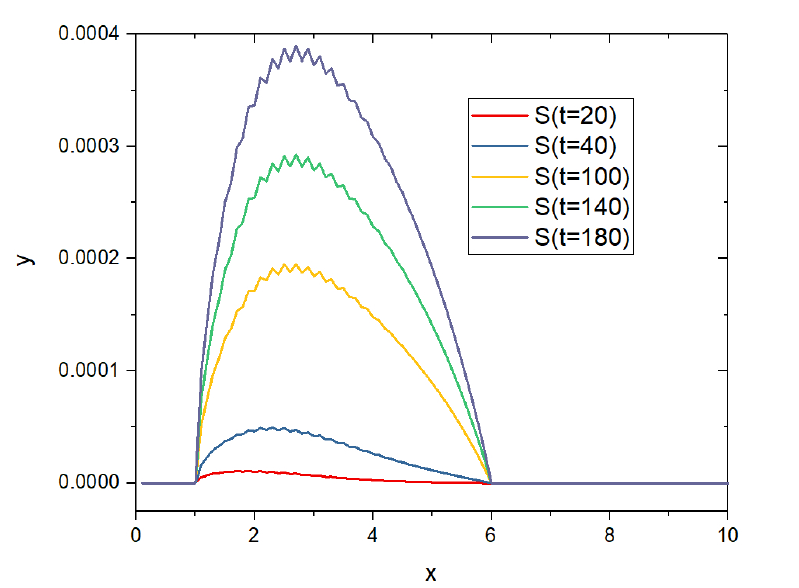
Figure 17. The thickness of the deposition is given by the motion of S ( t ) , plotted here at 5 instants of time, with respect to the x -axis (in mm). Notice that the motion t → S ( t ) is very small; the oscillations are blown-out of proportion by the scaling used in the